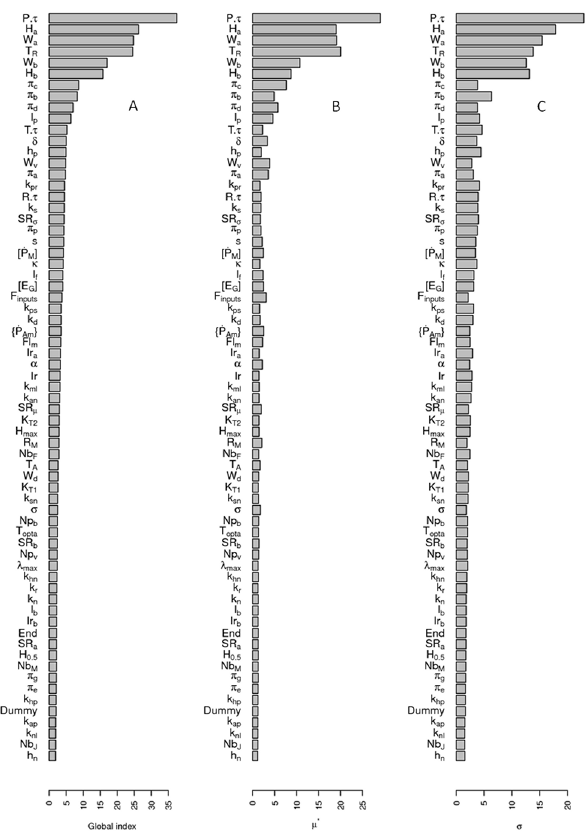
Fig 3. Morris ’ global index (A), mean of the elementary effects (B) and standard deviation of the elementary effects (C) determined for the IBM of the zebrafish population dynamics. Presented indices were the mean of the indices determined for the total number of fish, the frequency of adult/juvenile, the mean length of adults and juveniles at 1095, 1156, 1217, 1277, 1339, 1400 days from the beginning of the simulations. Sensitivity analysis indices were calculated on the mean of 30 model repetitions for each parameter combination. "Dummy" is a parameter with no influence on the model outputs. The other parameters are presented Tables 1, 2 and